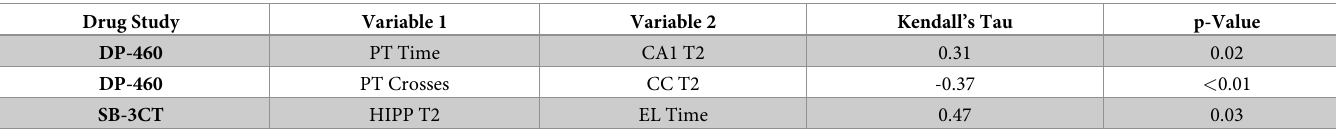
Table 2. Significant Kendall’s Tau correlations for DP-460 and SB-3CT drug